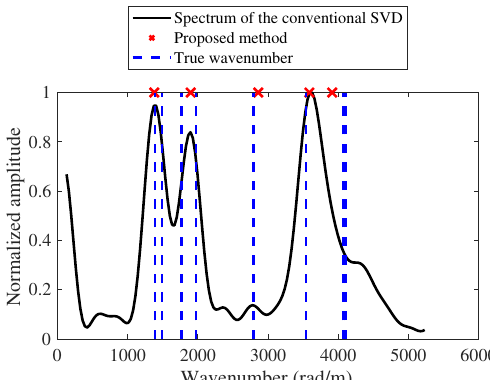
Figure 8. Depiction of the wavenumbers obtained using the proposed method and the spectrum obtained using the conventional method at 1.0 MHz. This is the cross-sectional view at the white dotted line shown in Figure 7. The vertical blue dotted lines indicate the theoretical